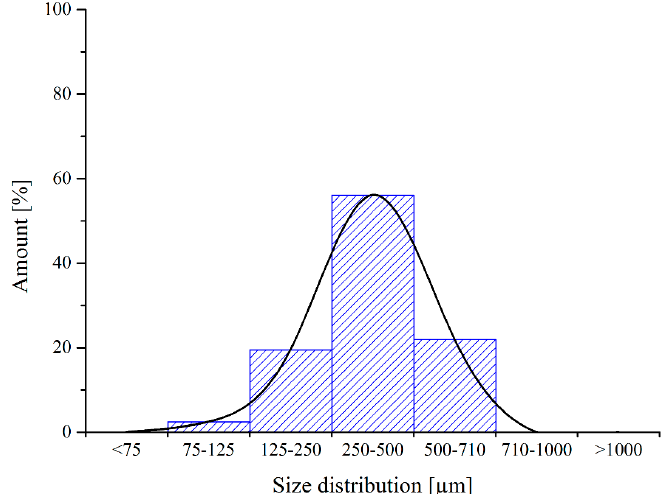
Figure 3. Size distribution of RP .